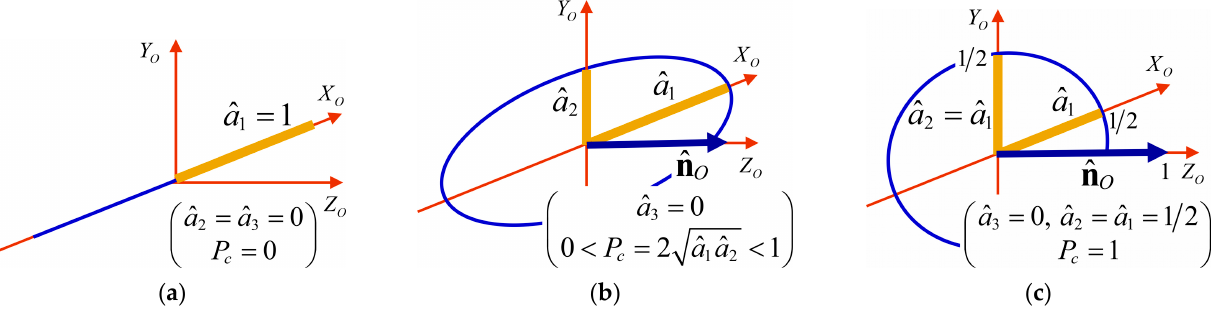
Figure 2. Polarization density object of a pure state ( P e = 1 ) : linearly polarized state ( P l = 1 ) ( a ); elliptically polarized state ( 0 < P c < 1 ) ( b ), and circularly polarized state ( P c = 1 ) ( c ). The spin density vector of pure states is orthogonal to the variance ellipse and is zero in the case of linearly polarized